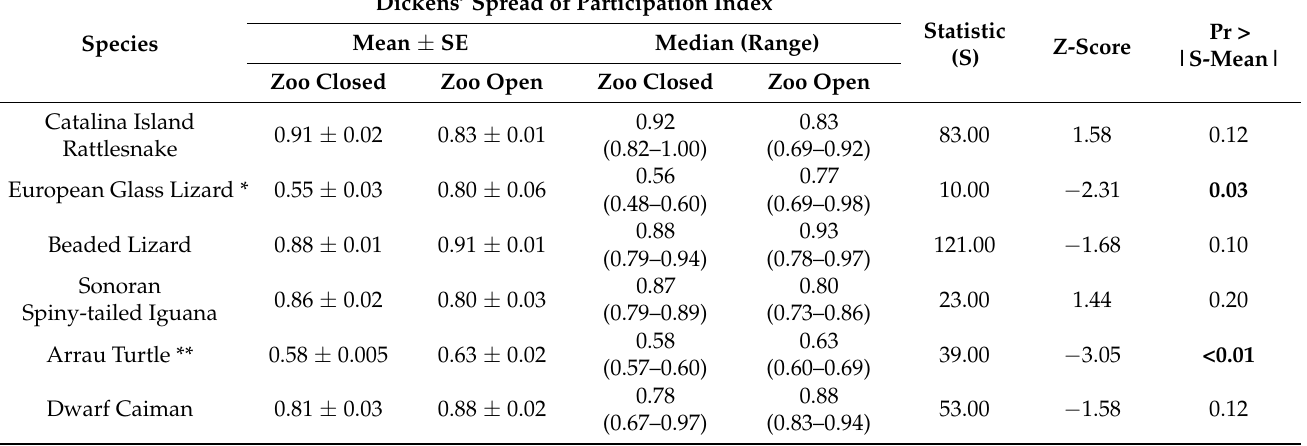
Table 8. Wilcoxon Two-Sample with Monte Carlo Exact Test Results for Dickens’ Spread of Participa- tion Index (SPI). Significant differences (Pr > |S-Mean| below 0.05) are bolded with an asterisk (*), and Pr > |S-Mean| equal to 0.01 or below are bolded with a double asterisk